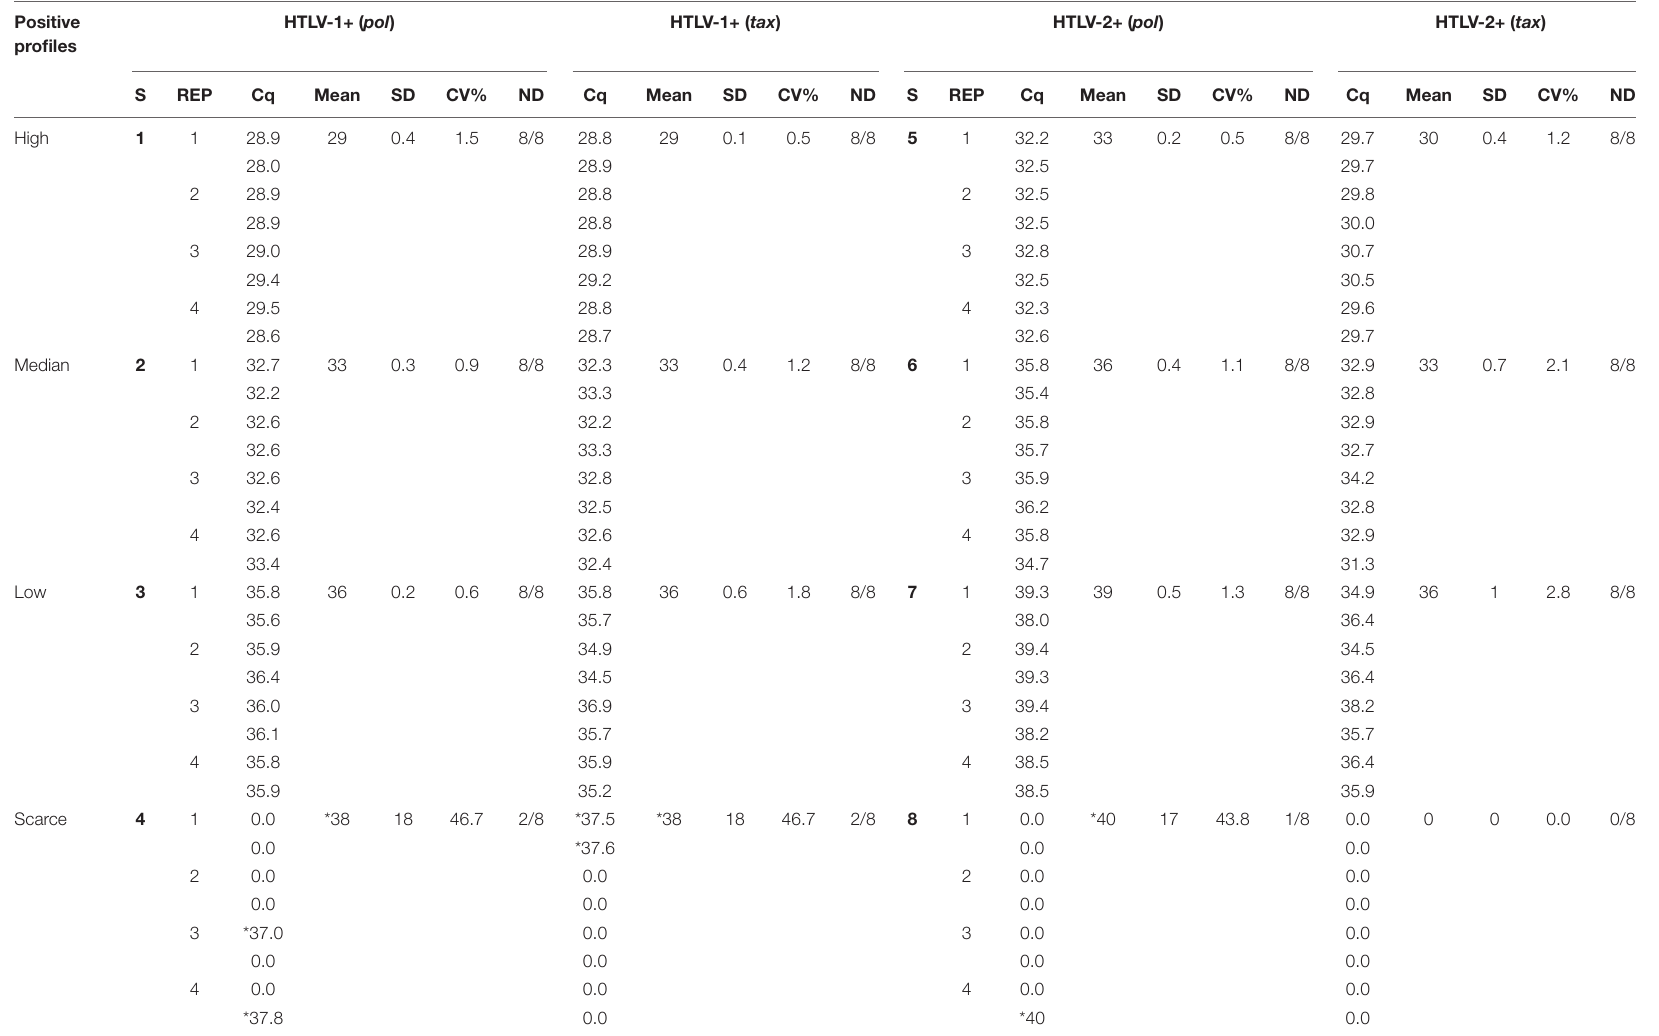
TABLE 8 | Intra- and inter-assay reproducibility of mqPCR_HTLV assays ( pol and tax ) for detecting HTLV-1 and HTLV-2 using DNA samples from eight individuals with different positive Cq profiles, in duplicate and in four consecutive days of analysis. Positive profiles